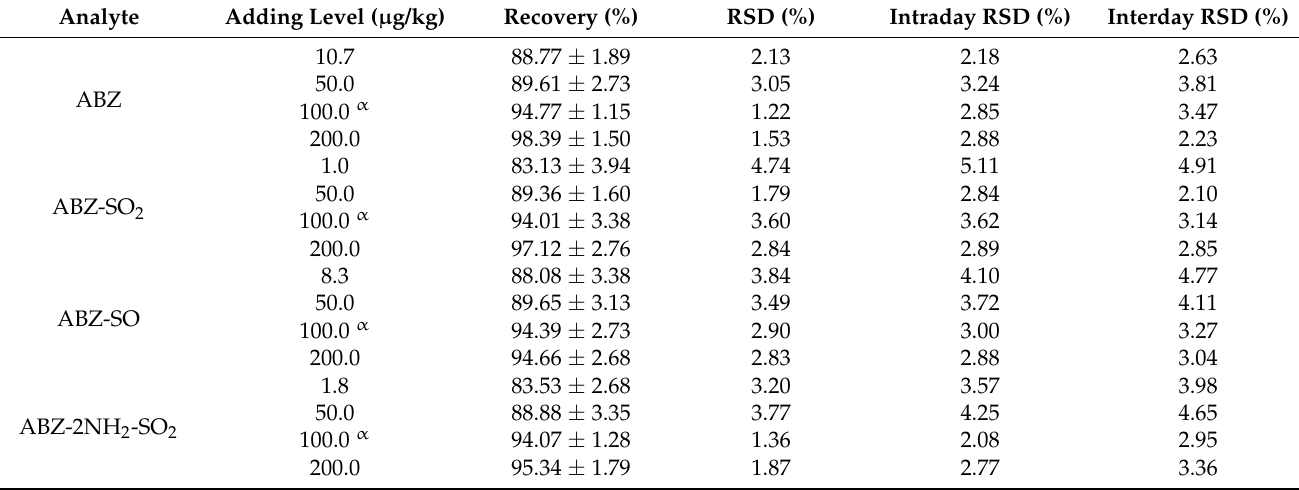
Table 4. Recovery and precision of ABZ, ABZ-SO 2 , ABZ-SO and ABZ-2NH 2 -SO 2 added to blank chicken muscle (n = 6). Analyte